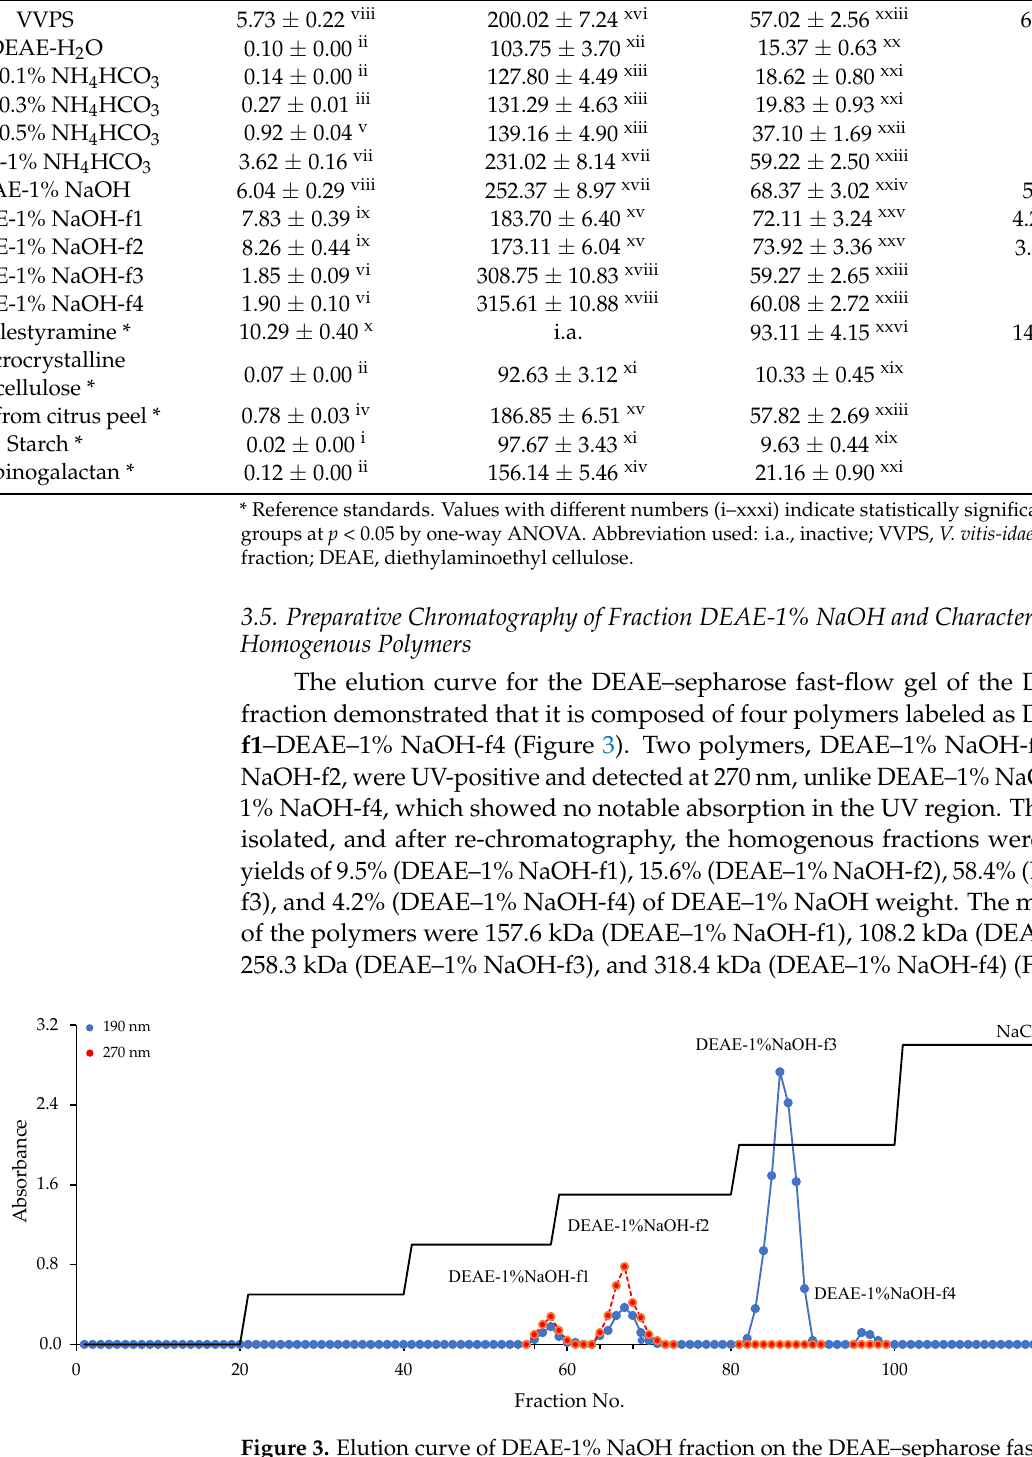
Figure 3. Elution curve of DEAE-1% NaOH fraction on the DEAE–sepharose fast-flow